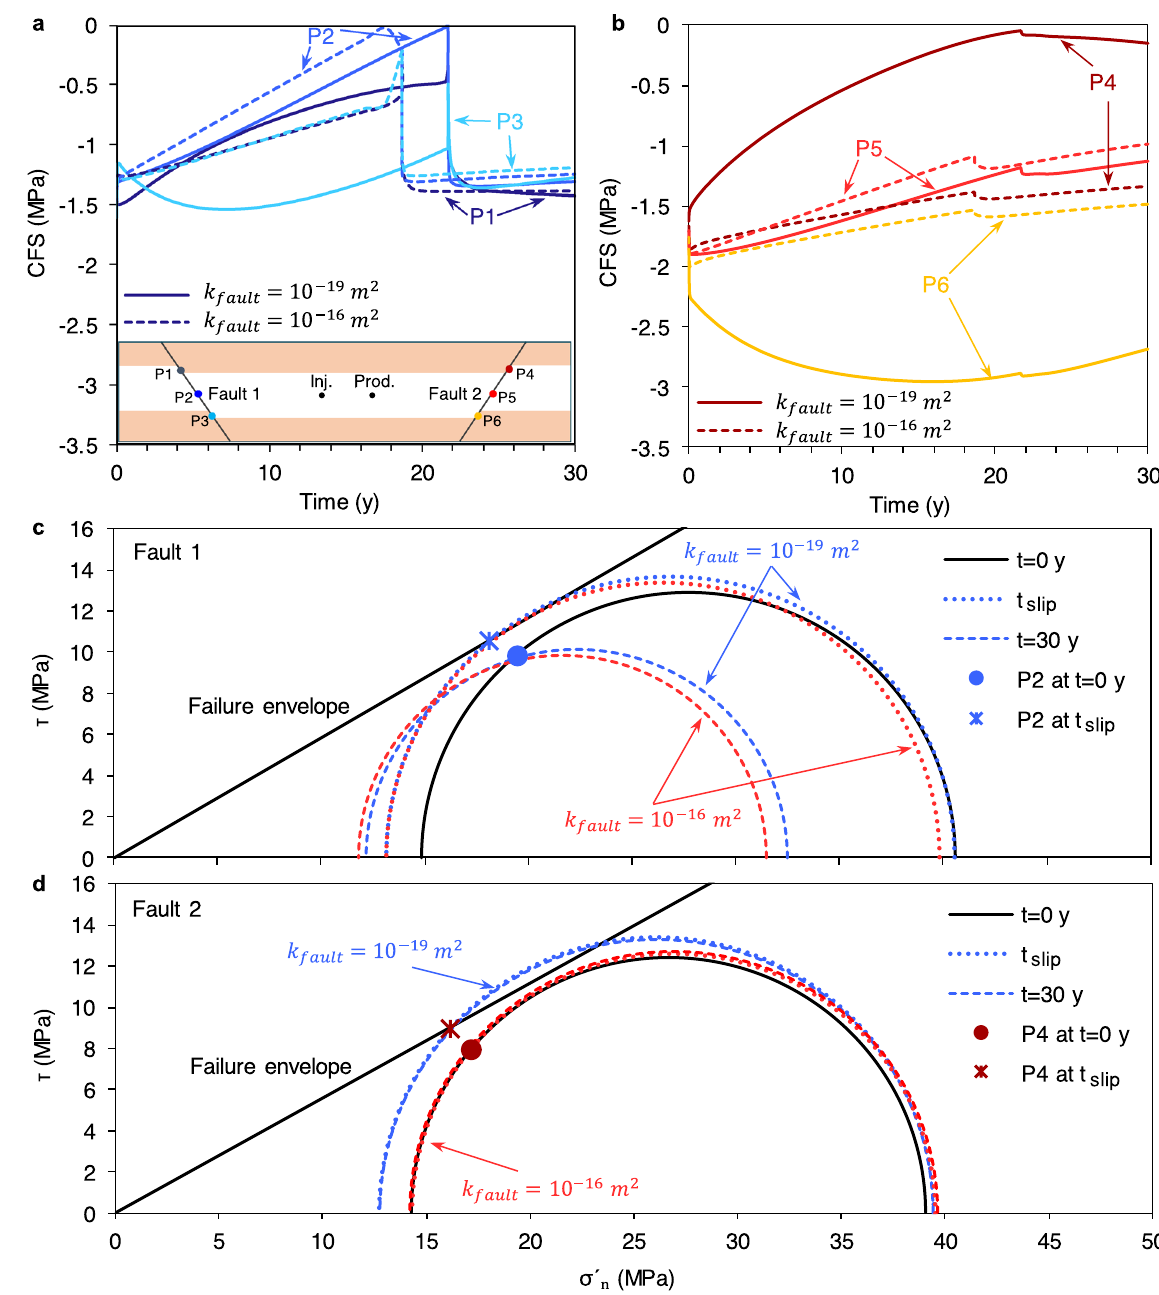
Figure 6. Impact of fault permeability on its stability. Evolution with time of the slip tendency (CFS) at the top, middle and bottom of fault 1 ( a , corresponding to dark to light blue, respectively) and fault 2 ( b , corresponding to brown, red and orange, respectively). The most critical stability conditions are reached in the middle of fault 1 (point 2) and at the top of fault 2 (point 4). ( c , d ) Mohr circles are drawn at these two points before circulation (t = 0), and after t slip ( 18 and 21 years for high- and low- permeability faults, respectively) and t = 30 years of ≈ water circulation. One should note that minor stress changes on fault 2 occur after the slip; thus, Mohr circles of t slip and t = 30 years almost